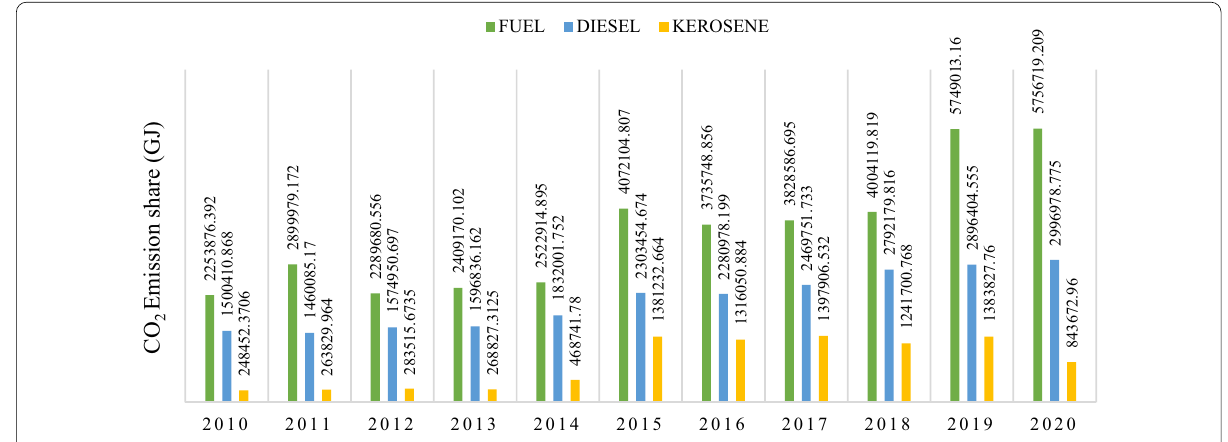
Fig. 1 Contributions of the energy mix to the change in CO 2